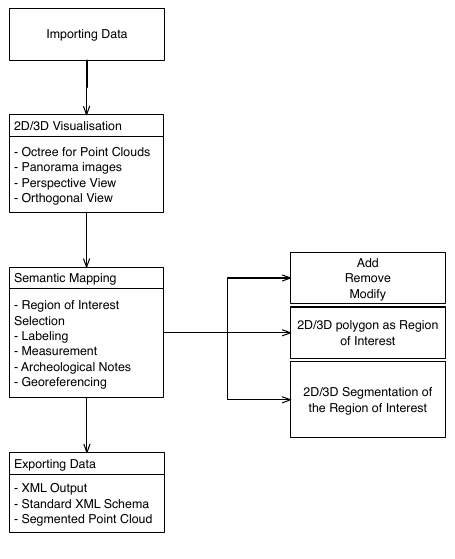
Figure 4: CASTLE3D Overview